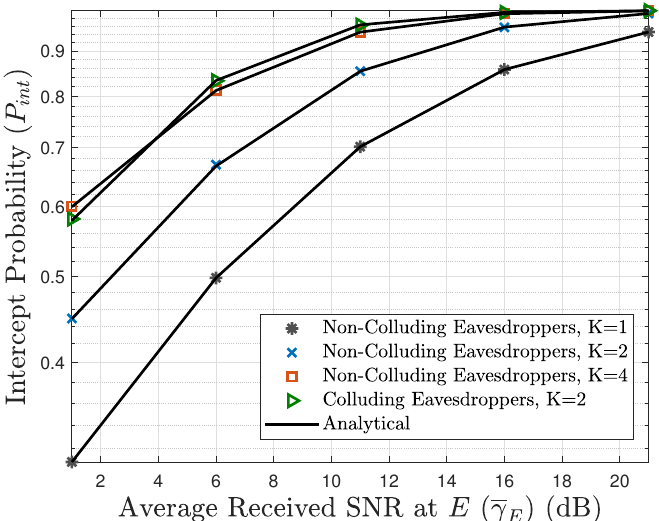
Figure 8. The intercept probability ( P int ) versus the average received SNR at E . For the main channel, κ = 1, µ = 1, and for the wiretap channel, κ e = 1, µ e = 1. ¯ γ B = 5 dB, N = 2, n e = 1, α = 2, λ e = 0.1, and i = 1.